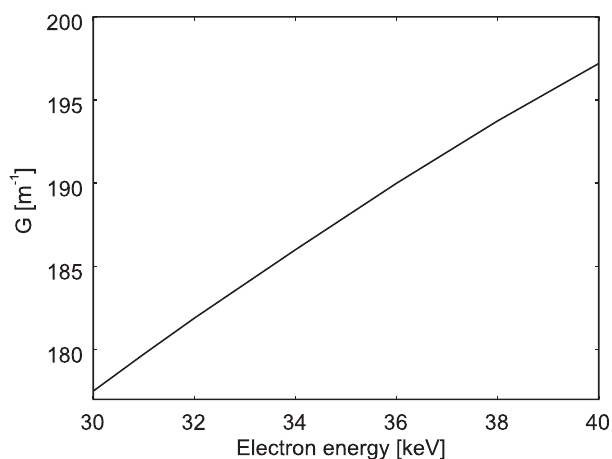
FIG. 5. Small signal gain for the experimental parameters of Ref.